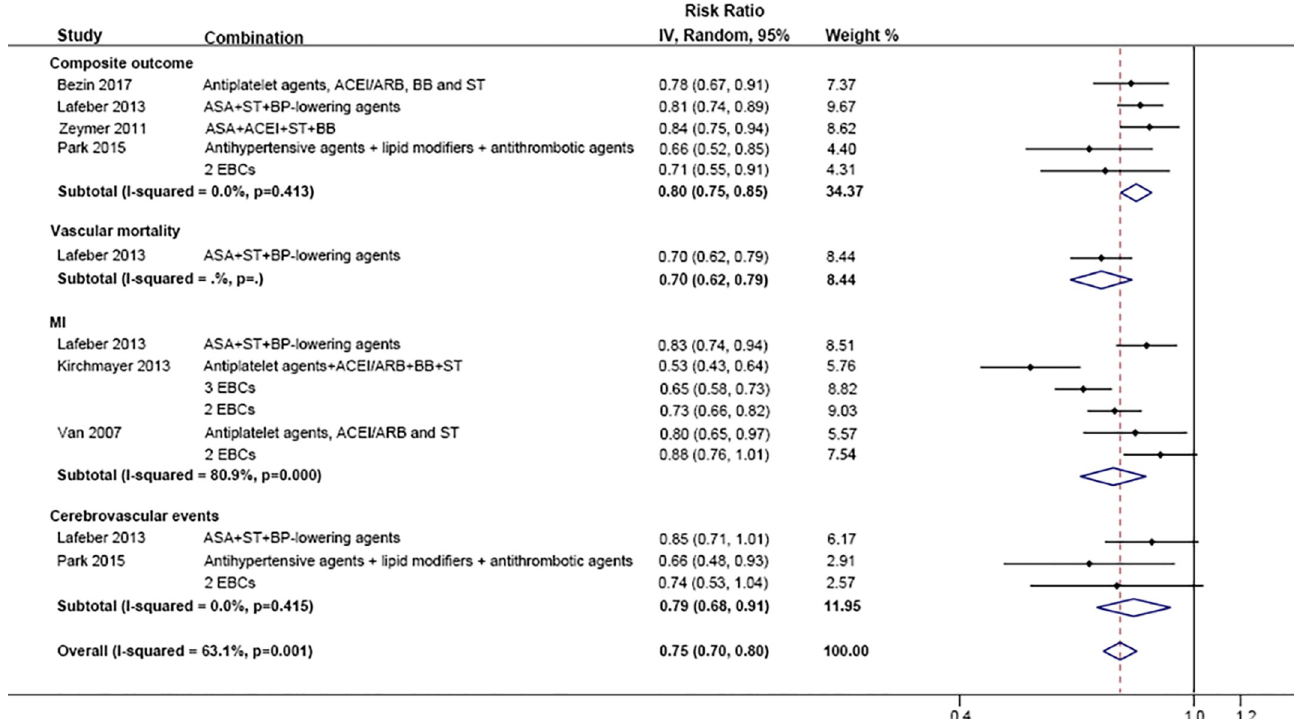
Fig 6. Comparison: EBCP versus 0–1 EB component, Outcome: Major CV events.